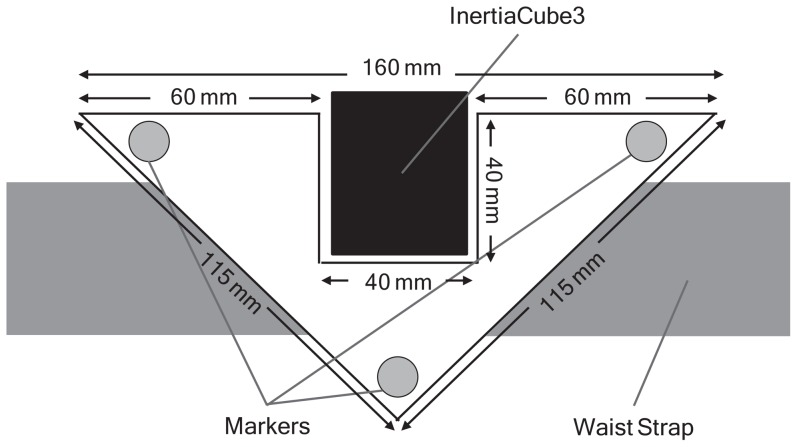
The three reflective markers attached to the custom-built rigid body positioned around the InertiaCube3 Inertial Measurement Unit.